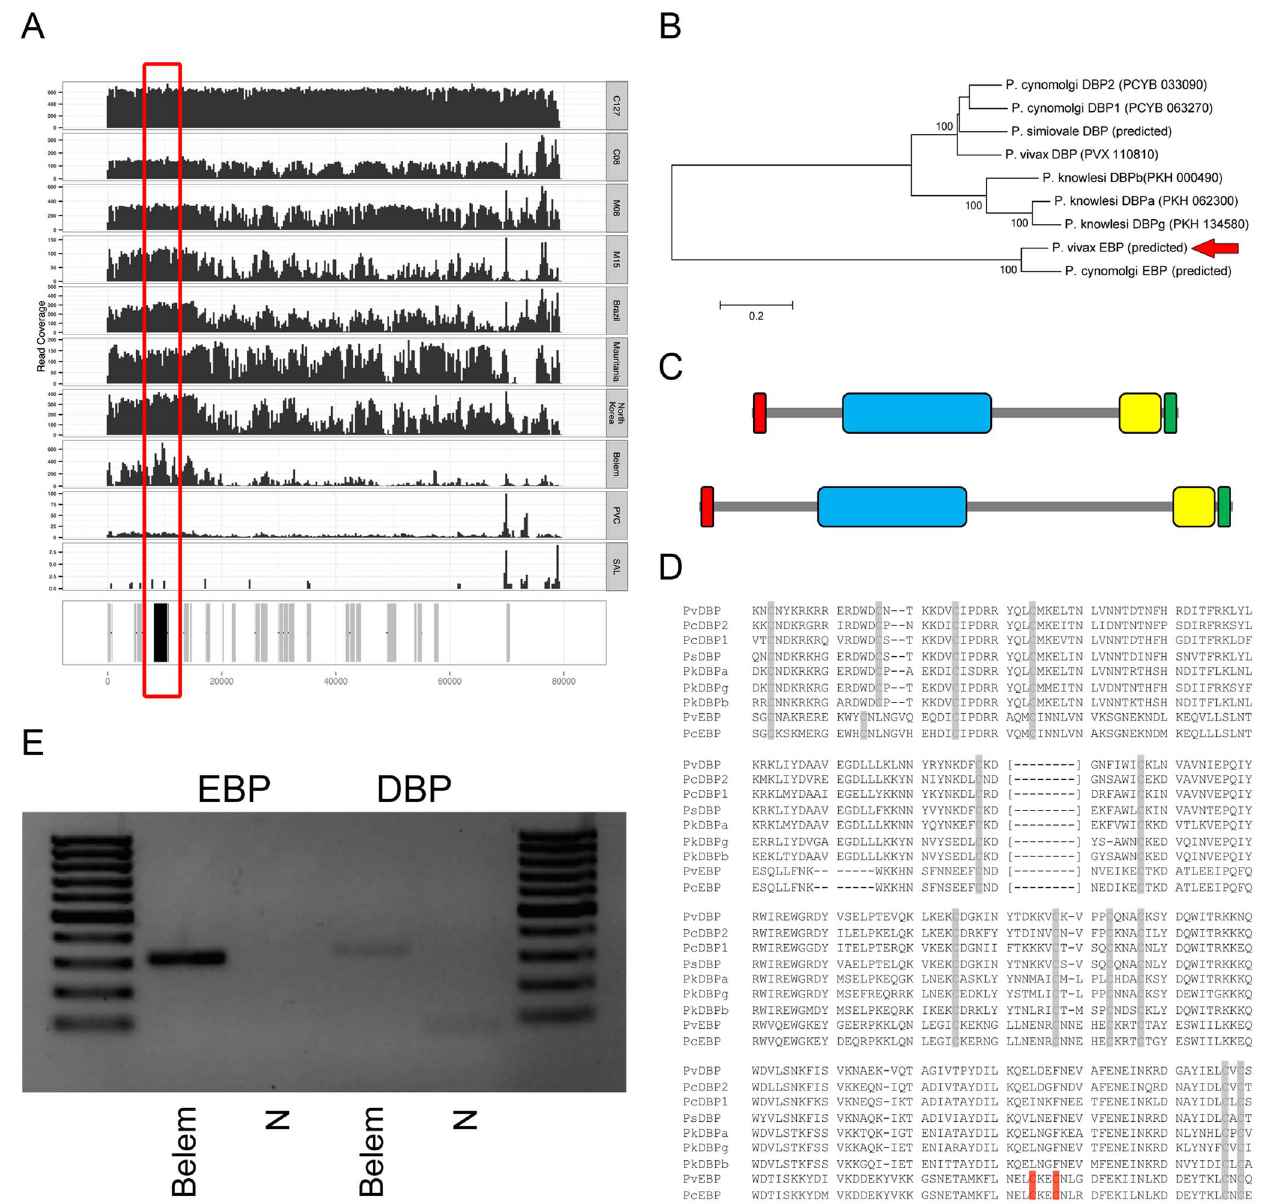
Figure 4. Novel P.vivax Erythrocyte-binding protein gene. ( A ) Sequence coverage along the 80 kb contig containing a novel predicted P. vivax Erythrocyte-Binding Protein gene. The bottom track shows, in grey, predicted protein coding genes and, in black, the position of the predicted EBP gene (also highlighted by the red box). The upper panels display next-generation sequencing read coverage along the contig sequence. The samples are from top to bottom: C127, C08, M08, M15, Brazil I, Mauritania I, North Korea, Belem, Chesson and Salvador I. Note that in the Salvador I sample, there are essentially no reads mapping to this contig. ( B ) Phylogenetic tree showing the relationships among EBP protein sequences from P. vivax , P. cynomolgi , P. simiovale and P. knowlesi . The position of the novel predicted P. vivax EBP gene is highlighted by the red arrow. ( C ) Comparison of the protein domain annotations for the novel predicted EBP gene (top) and the known P. vivax DBP gene. The red box indicates the signal sequence; the blue box the Duffy-binding like domain; the yellow box the C-terminus cysteine-rich domain and the green box the transmembrane domain. ( D ) Amino acid alignment of the Duffy-binding like domain for different Plasmodium DBP genes and the novel P. vivax and P. cynomolgi EBP genes. The alignment shows the amino acid positions 215–509 of PvDBP (the section of the alignment not displayed corresponds to amino acid 303– 371). The grey boxes indicate conserved cysteine positions. The red boxes indicate the positions of two additional cysteines present in the novel EBP genes. ( E ) The novel P. vivax EBP gene is expressed in blood-stage parasites. The gel picture shows the PCR products for the novel EBP gene (left) and known DBP gene (right) amplified from cDNA of the Belem strain. Note that, for both genes, the primers are located on either side of an intron and that the product size is consistent with amplification of cDNA molecules and excludes DNA contamination. doi:10.1371/journal.pntd.0002569.g004 genes were not systematically deleted from the P. vivax genome contigs assembled from the C127 sample revealed that none of the novel DNA sequences were systematically absent from monkey- during host switch. In fact, mapping next-generation sequencing reads generated from various monkey-adapted strains on all adapted stains. This observation suggests that genomic adaptations